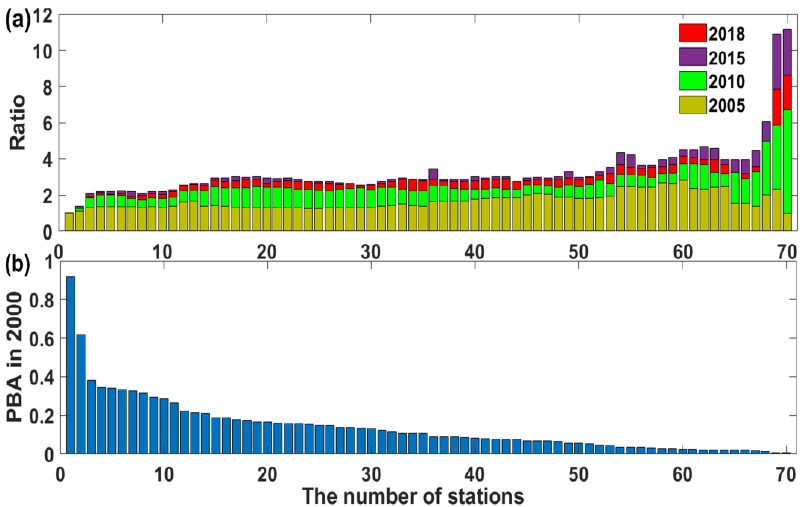
Figure 3. ( a ) The ratio of PBA in 2005, 2010, 2015 and 2018 to that in 2000. ( b ) the PBA in the year 2000.